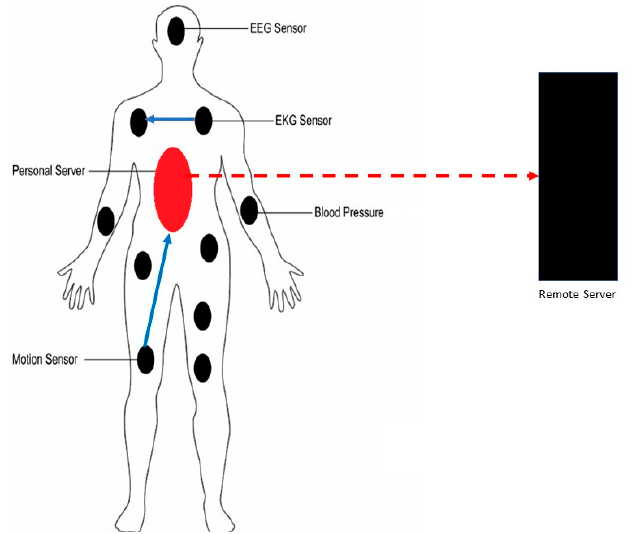
Figure 1. A Wireless Body Area Network (WBAN) contains two types of nodes, personal server (PS) and physiological signal sensors; the sensors cannot send any data to a remote server except through PS.